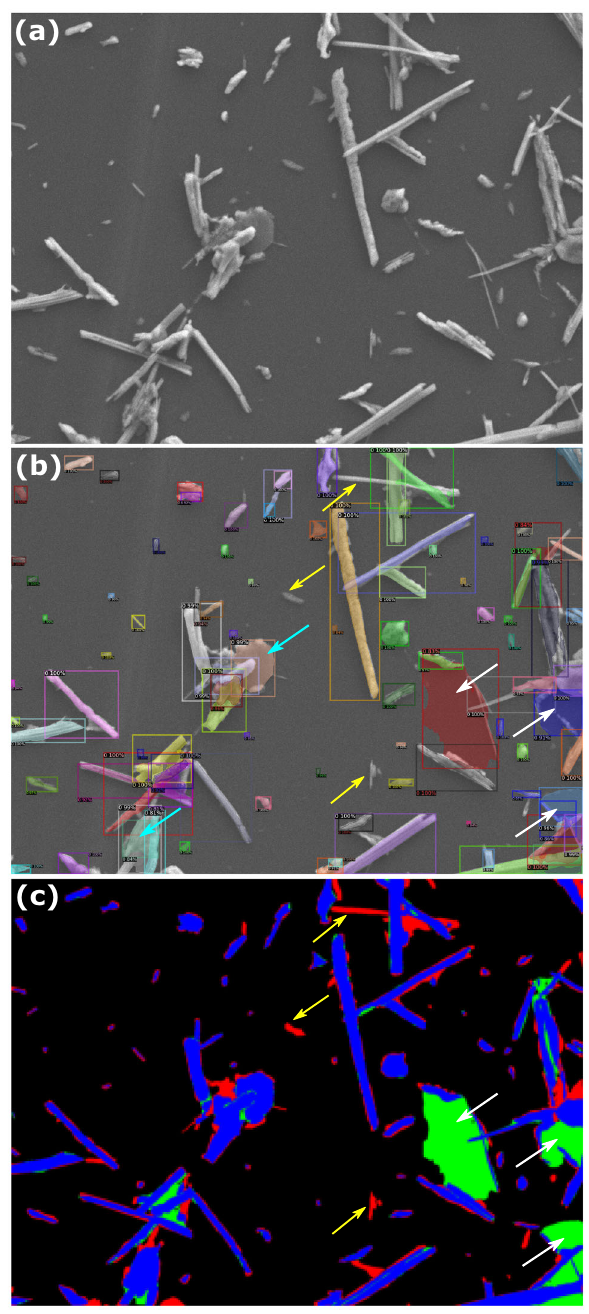
Fig. 8 Model prediction on V 2 O 5 nanowires within SEM image (957 × 1280 pixels). a Test image. b Predicted instance masks with lower opacity plotted on the test image. The best performer in AP segmentation mask in Table 4 was used to visualize the prediction masks in b . c Semantic binary mask. While suf fi ciently good segmentation results are found for overlapping nanowires, several FN pixeled nanowires, indicated by yellow arrows in b were missed by the model. Further discrepancies can be found in the region of agglomeration denoted by FP pixels and white arrows. The absence of optical density information combined with the distinct mode of contrast relative to STXM and X-ray ptychography contribute to the comparably lower prediction